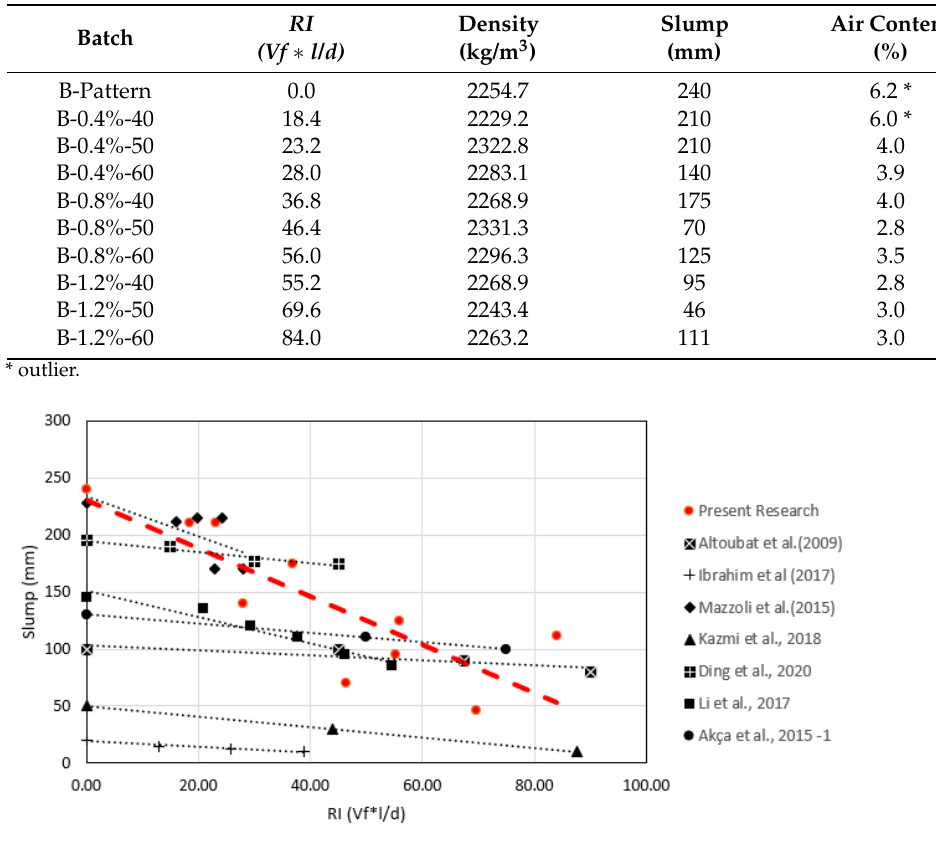
Figure 5. The slump as a function of the RI .